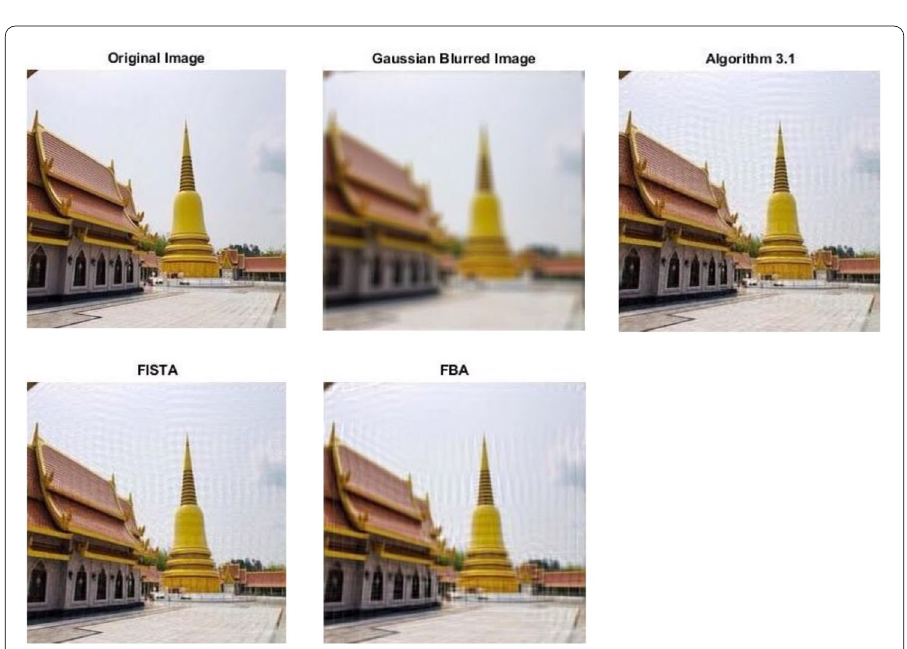
Figure 4 Results for Wat Boonyawad’s deblurring